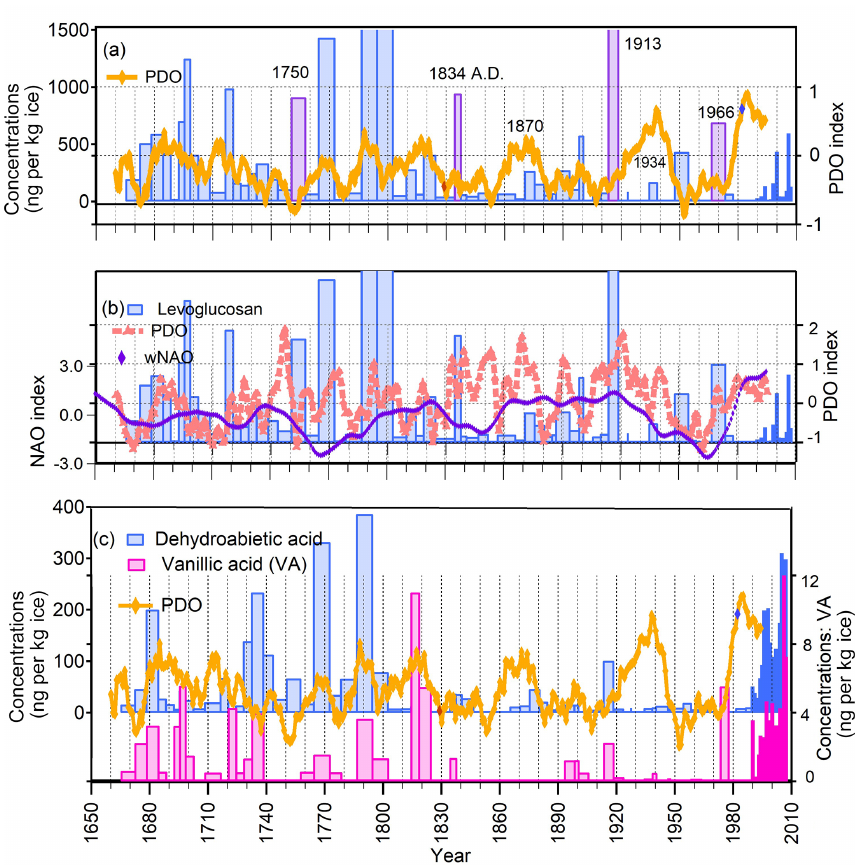
Figure 7. Historical trends in the concentrations of (a) levoglucosan (Aurora Peak) and Pacific Decadal Oscillation (PDO 5-year mean) index (Shen et al., 2006); (b) levoglucosan (Aurora Peak), PDO 5-year mean index (MacDonald and Case, 2005) and Multi-decadal Winter North Atlantic index (wNAO; Trouet et al., 2009); and (c) dehydroabietic and vanillic acids and PDO index (Shen et al., 2006) for